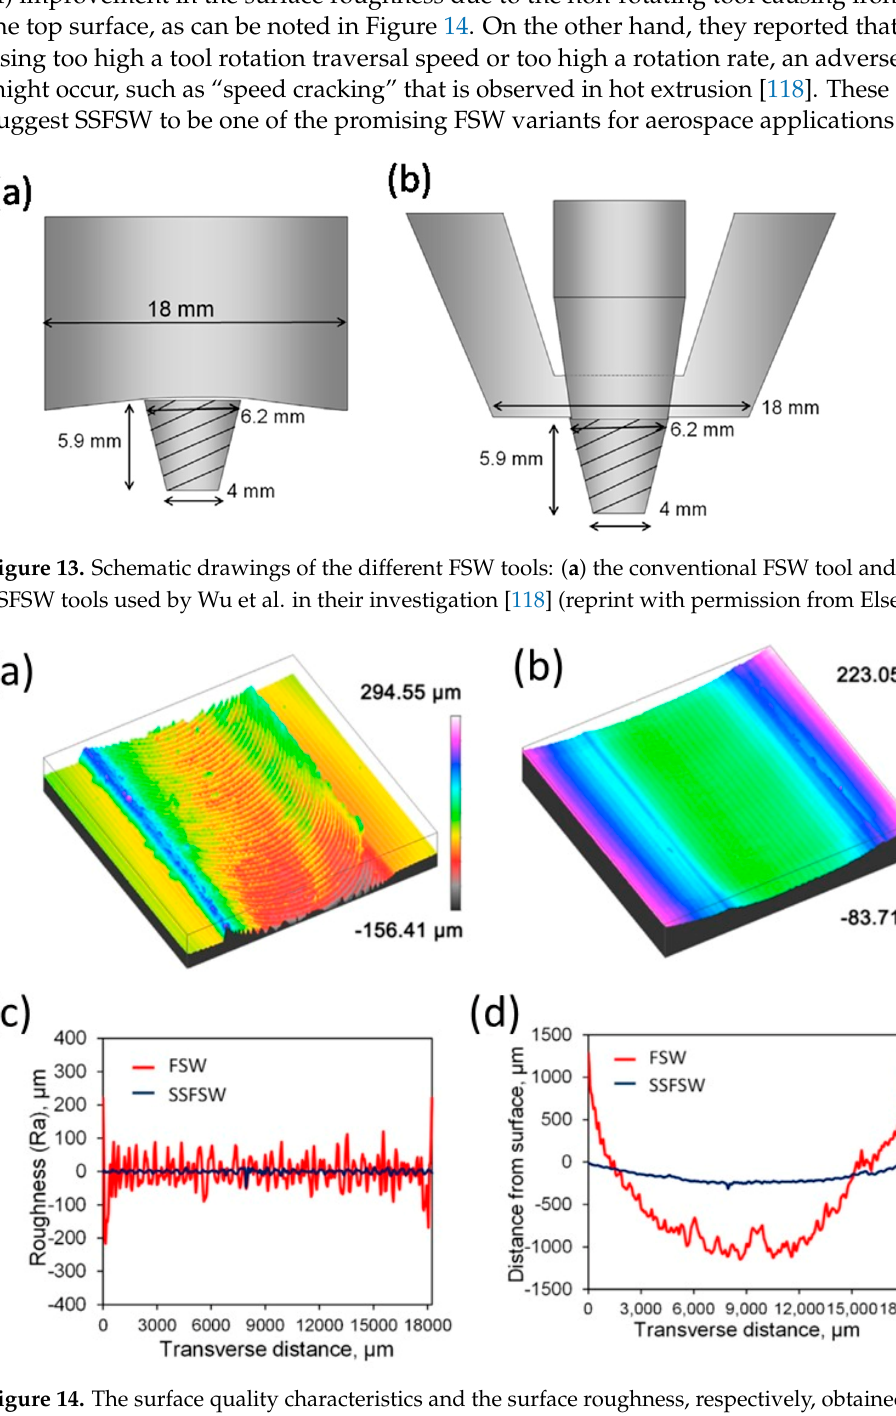
Figure 14. The surface quality characteristics and the surface roughness, respectively, obtained us- ing ( a , c ) conventional FSW tool and ( b , d ) SSFSW tool [118] (has permission from Elsevier).